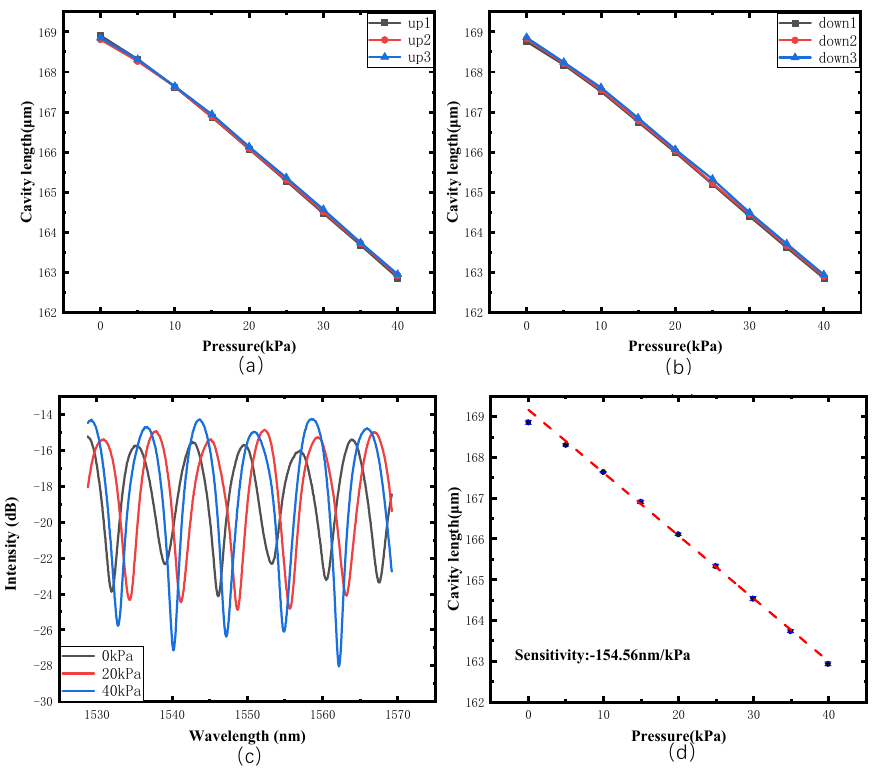
Figure 15. Response of FP cavity length to pressure. ( a ) relationship between the cavity length change and pressure in uploading process, ( b ) relationship between the cavity length change and pressure in downloading process, ( c ) spectrum changes during the pressure loading process, ( d ) a linear fitting of experimental results.